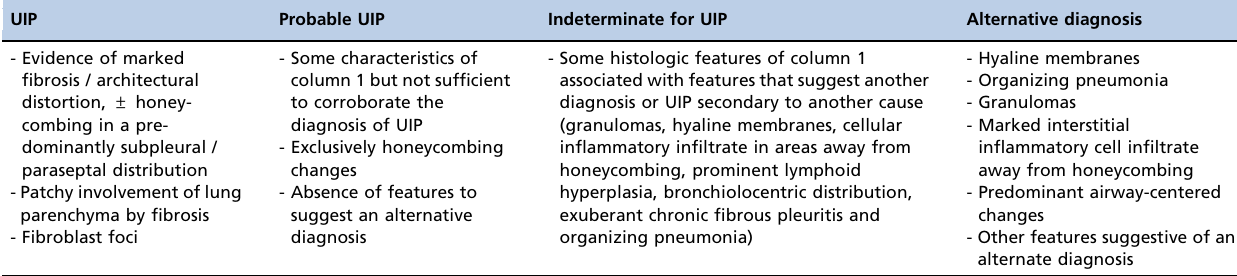
Table 2 - Histopathological Criteria for the UIP